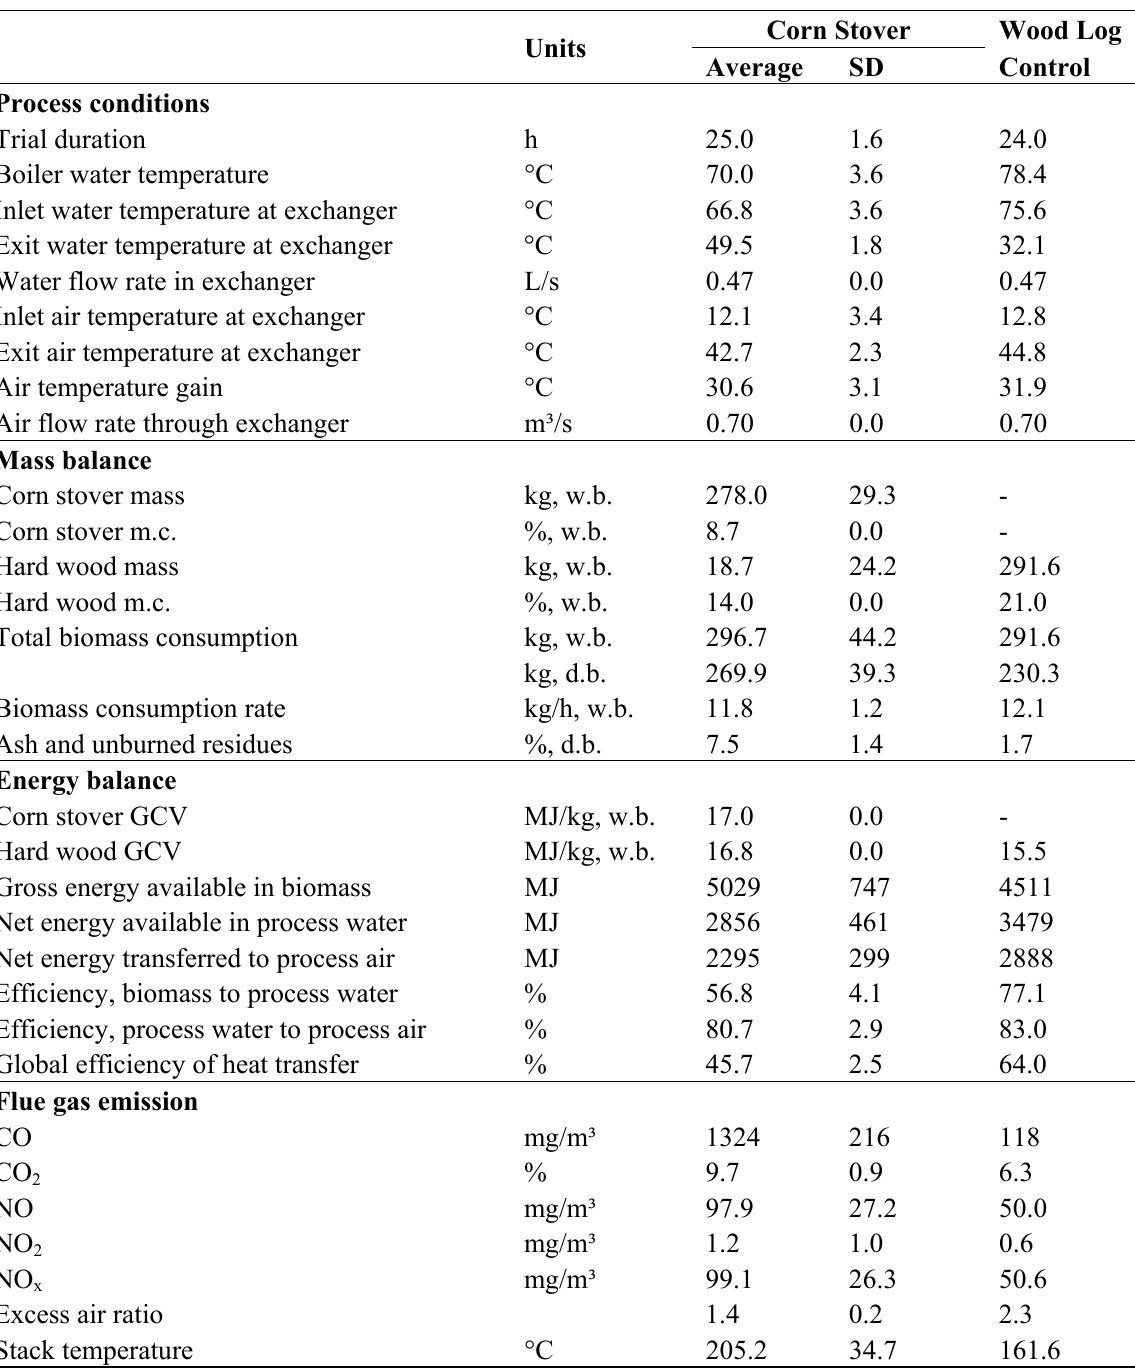
Table 2. Average and standard deviations (SD) of process conditions, mass and energy balances and flue gas emissions for three corn stover combustion trials compared with wood log